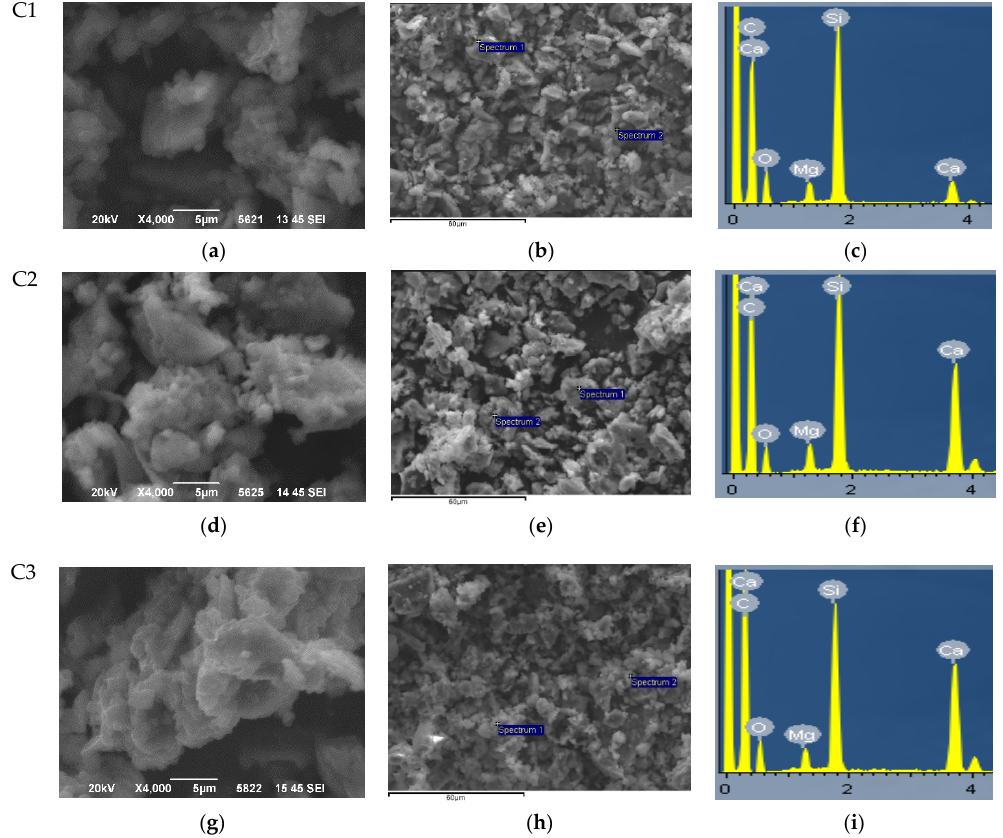
Figure 6. SEM-EDS analysis of the samples before the immersion in SBF (0 day): ( a , d , g ) SEM microphotographs, ( b , e , h ) microphotograph of backscattered electrons, ( c , f , i ) indicative EDS spectra (spectrum 1 in figures b , e , h ) of each sample.